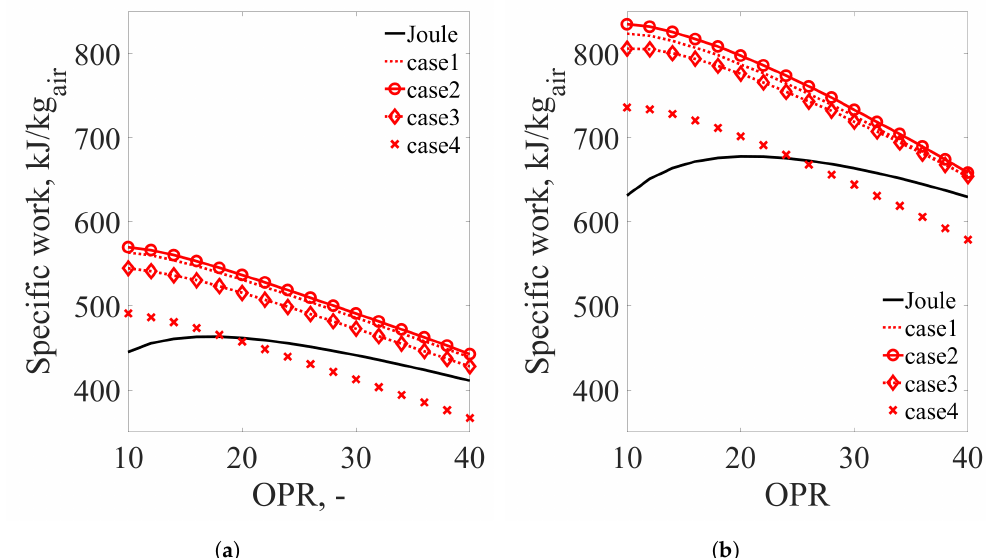
Figure 11. Specific work as a function of pressure ratio for the Joule cycle and the four versions of the Humphrey cycle presented in Table 3 and two TIT values. ( a ) Specific work for TIT 1300 ◦ C; ( b ) Specific work for TIT 1700 ◦